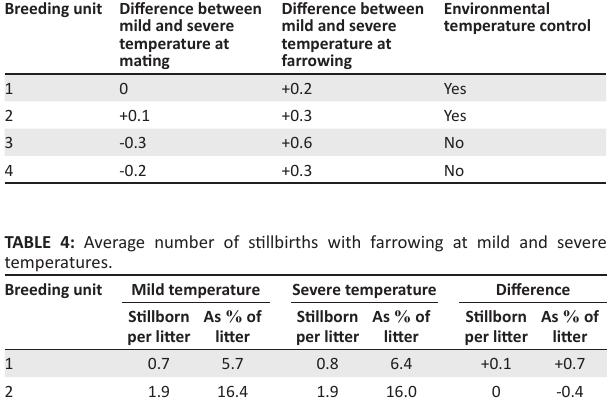
TABLE 3: Average litter size following mating and following farrowing at mild and severe temperatures in association with temperature control. Breeding unit Difference between Difference between mild and severe mild and severe temperature at temperature at mating farrowing